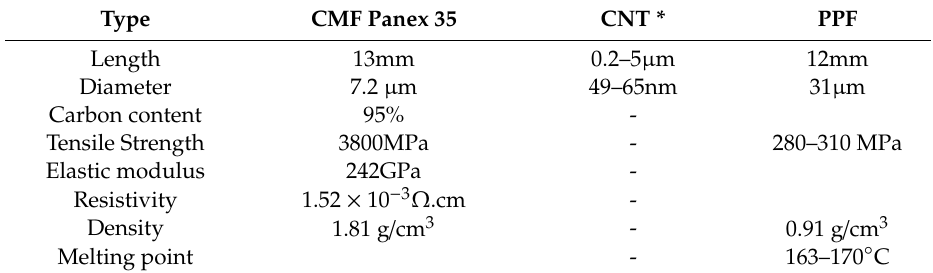
Table 3. Main characteristics of polypropylene fibers (PPF), carbon nanotubes (CNT), and carbon microfibers